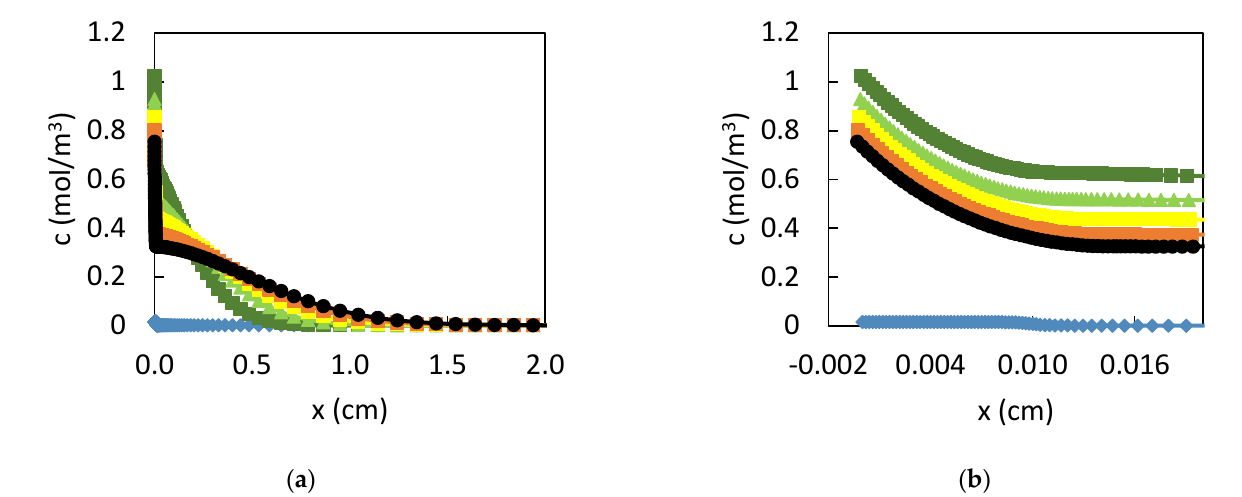
Figure 13. Evolution of the lead ion concentration in an electrolyte of 1000 mol/m 3 HCl and of size L = 10 cm with an initial CPL of 100 µm and a variable porosity ( a ) the first 2 cm and ( b ) the first 200 µm of the electrolyte are presented for different times t = 0 (light blue), 3600 (dark green) 7200s (green), 10,800 s (yellow), 14,400 s (orange), and 18,000 s (black).